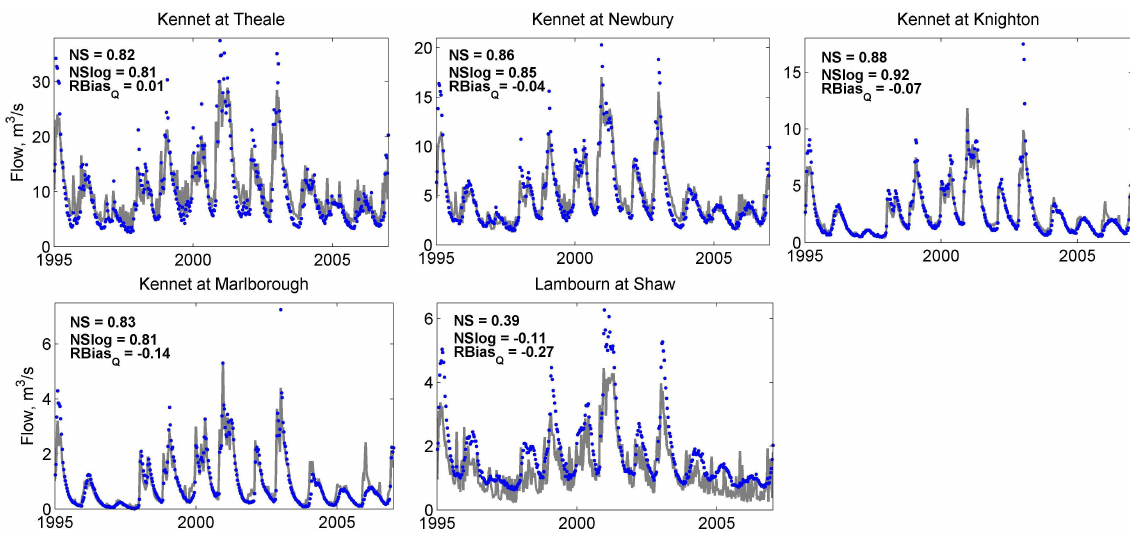
Figure 6. 10-day average flows at five gauging stations in the Kennet generated by the JULES + WG + PDM + CHALK + GW model configuration. Grey lines denote simulated flows, and blue dots are observations.